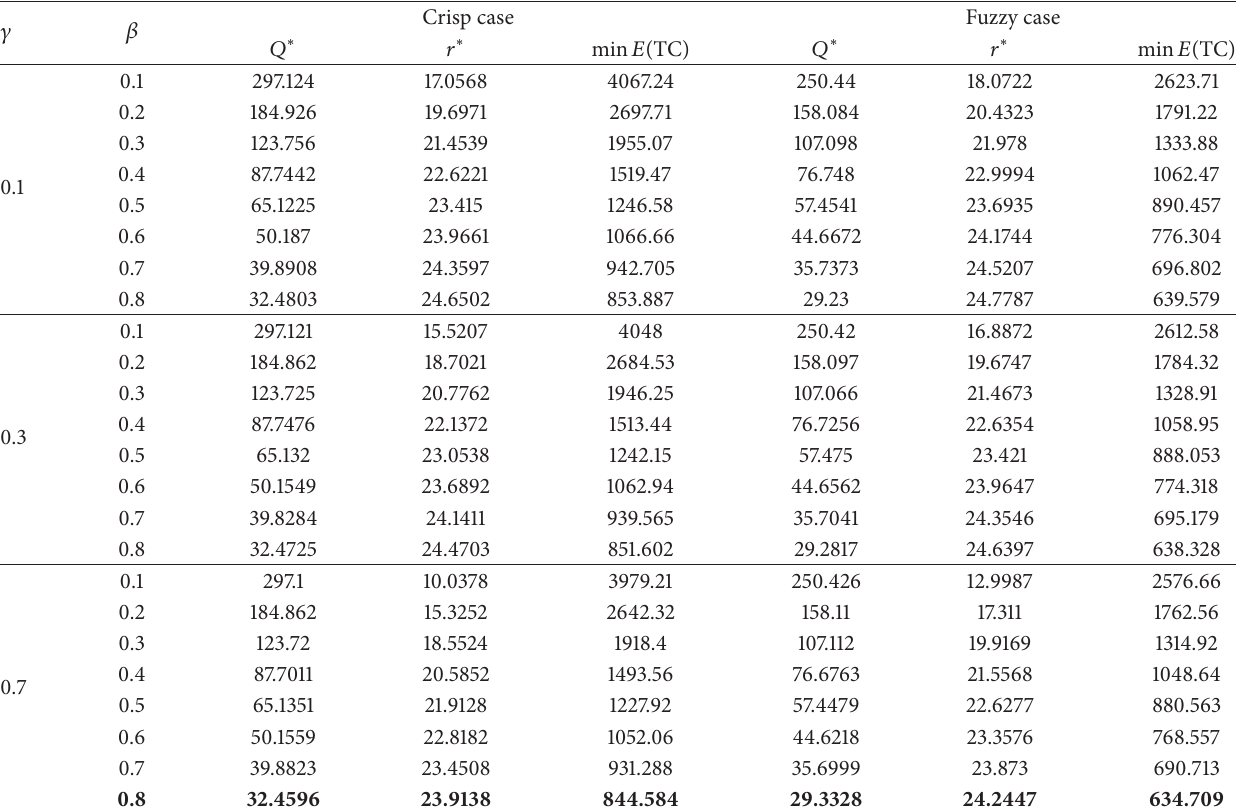
Table 3: The exact solutions and min 𝐸 (TC) for model (I) and model (I f ) at Uniform